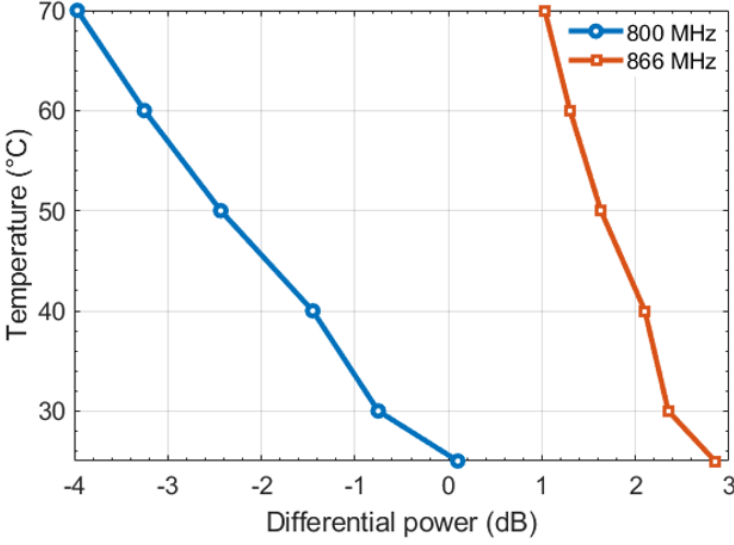
Figure 8. Temperature deducing using differential activation power method.